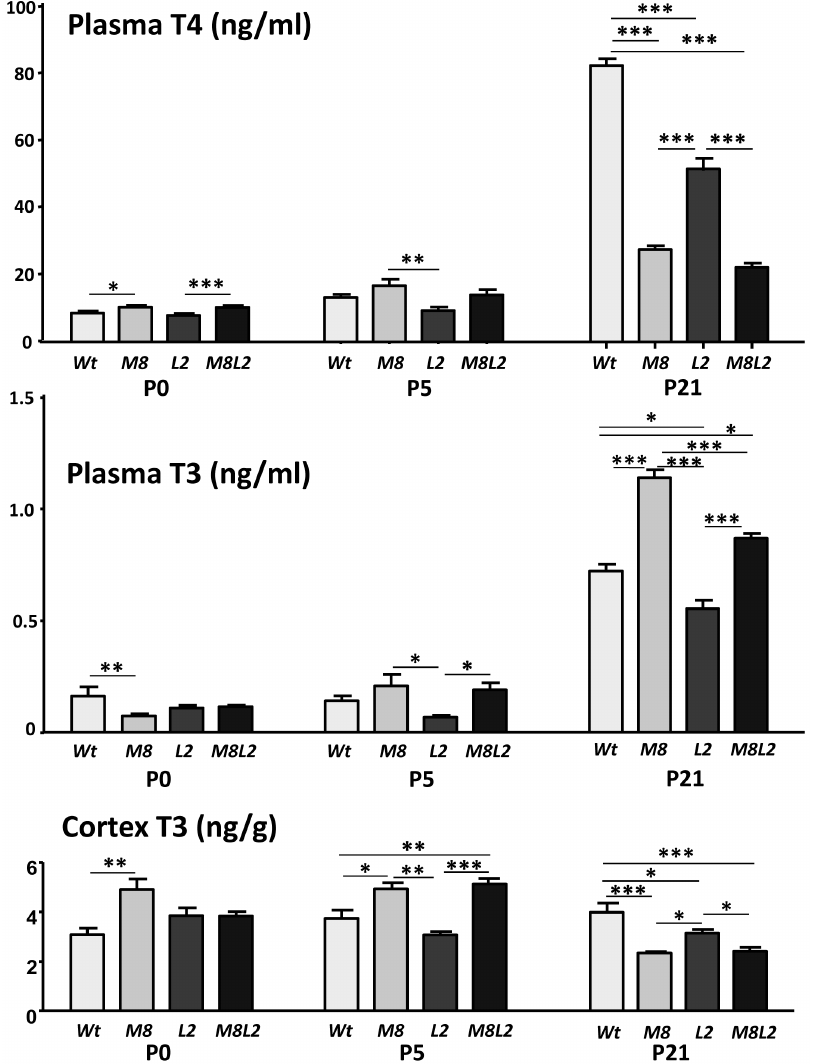
Figure 2. Plasma T4 and T3 and cortex T3 concentrations in mice of different genotypes and different ages, as indicated. Wt = wild type mice; M8= Mct8KO . L2= Lat2KO ; M8L2= Mct8Lat2KO . Significance of differences was calculated by one way ANOVA, and the Tukey posthoc test. Only relevant significant comparisons are indicated. * P , 0.05. ** P , 0.01. *** P , 0.001. P0, P5, and P21: postnatal days 0, 5, and 21, respectively.